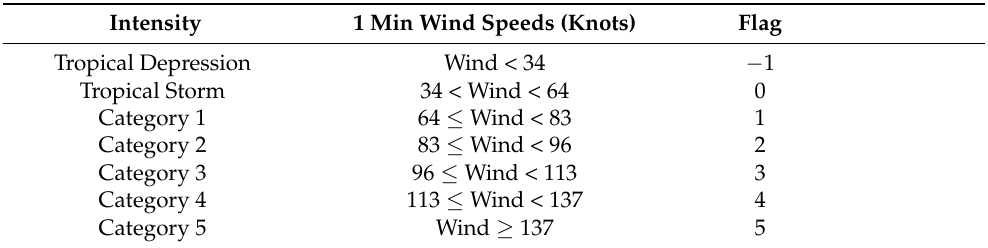
Table 1. Tropical systems classified based on the wind speed provided by the US agency wind speed [52].